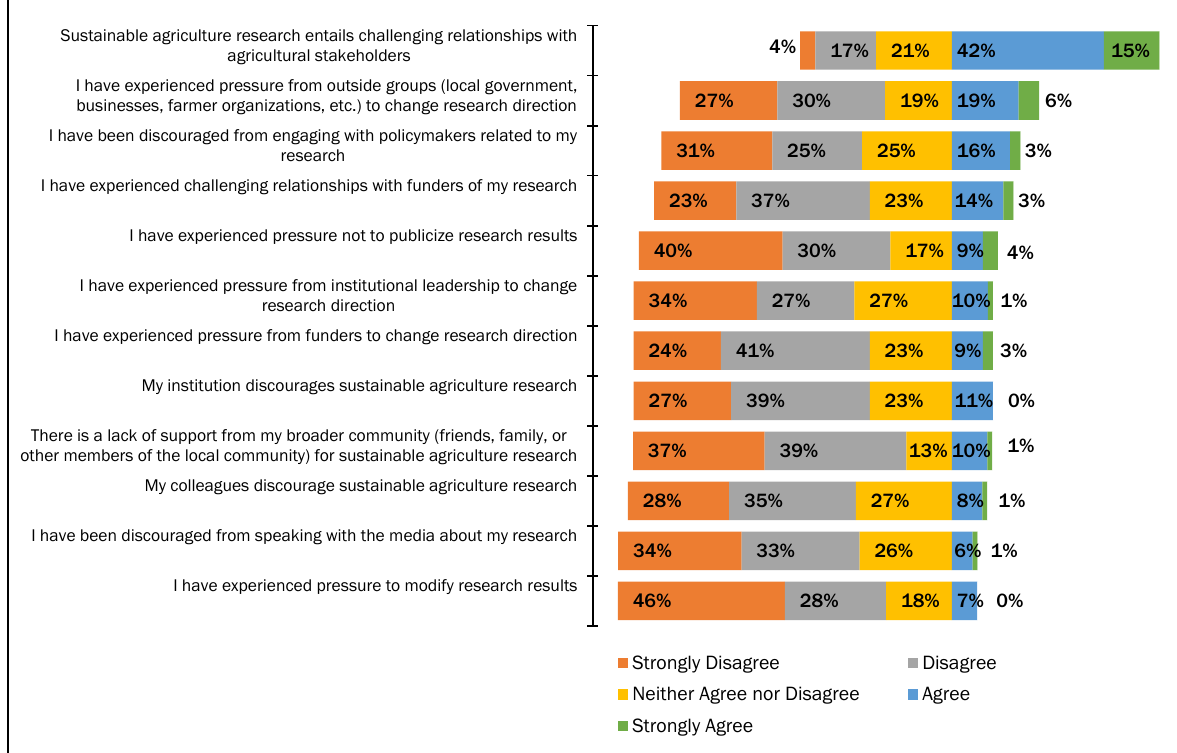
Figure 3. Experience with Obstacles in Sustainable Agriculture Research ( N